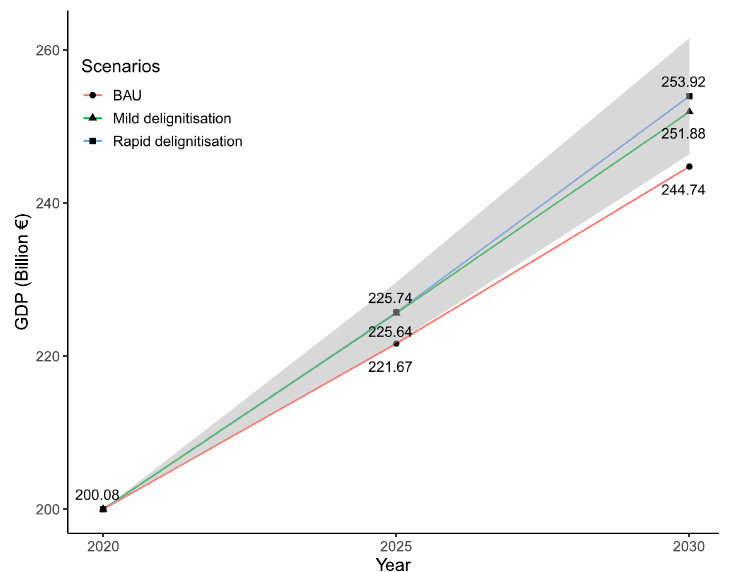
Figure 1. Graphical display of the evolution of the GDP of Greece over the 2020–2025 and 2026– 2030 periods under the BAU, mild, and rapid delignitization scenarios. The grey area indicates the 95% Confidence Interval (CI) of the rapid delignitization scenario’s pathway with respect to model parameters’